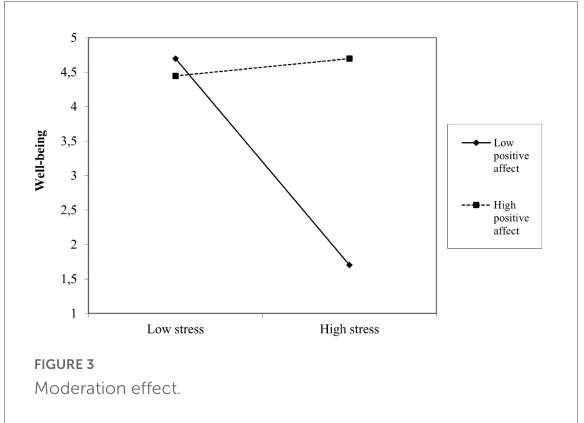
FIGURE3 Moderation